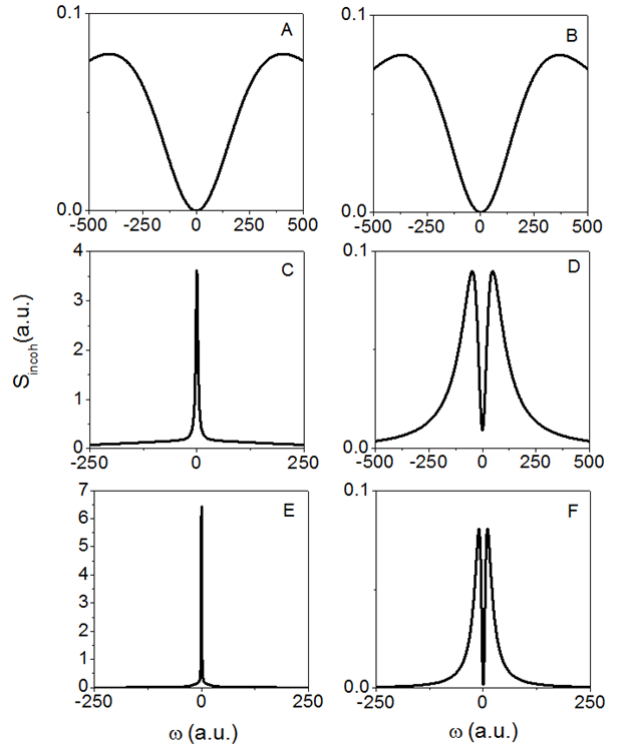
Figure 3. Spectrum of the fluctuations calculated using eq. (57) for marked points of Figure 2 with different values of x